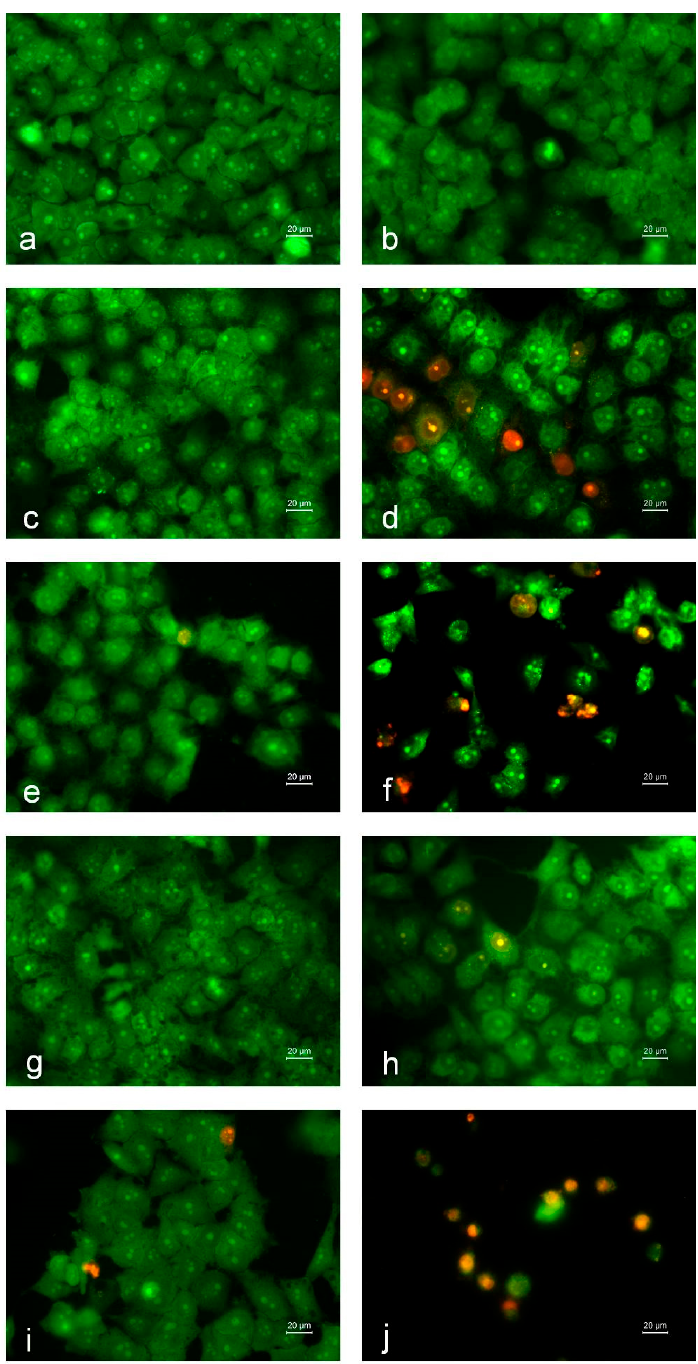
Figure 10. Fluorescence micrographs of AO and EtBr double-stained HeLa tumor cells incubated in the presence of different formulations (fibrous mats or solutions) for 24 h. Cells after incubation with: ( a ) untreated HeLa cells, ( b ) crPVA mat, ( c ) cr(PVA/Ch) mat, ( d ) cr(PVA/Ch)/SQ mat, ( e ) Fe 3+ complex of cr(PVA/Ch)/SQ mat, ( f ) Cu 2+ complex of cr(PVA/Ch)/SQ mat, ( g ) aqueous solution of Ch, ( h ) aqueous solution of SQ, ( i ) solution of SQ.Fe 3+ and ( j ) solution of SQ.Cu 2+ ; scale bar = 20 µm. All SQ-containing formulations and their complexes were tested at a concentration of SQ 340 µg/mL of culture medium.